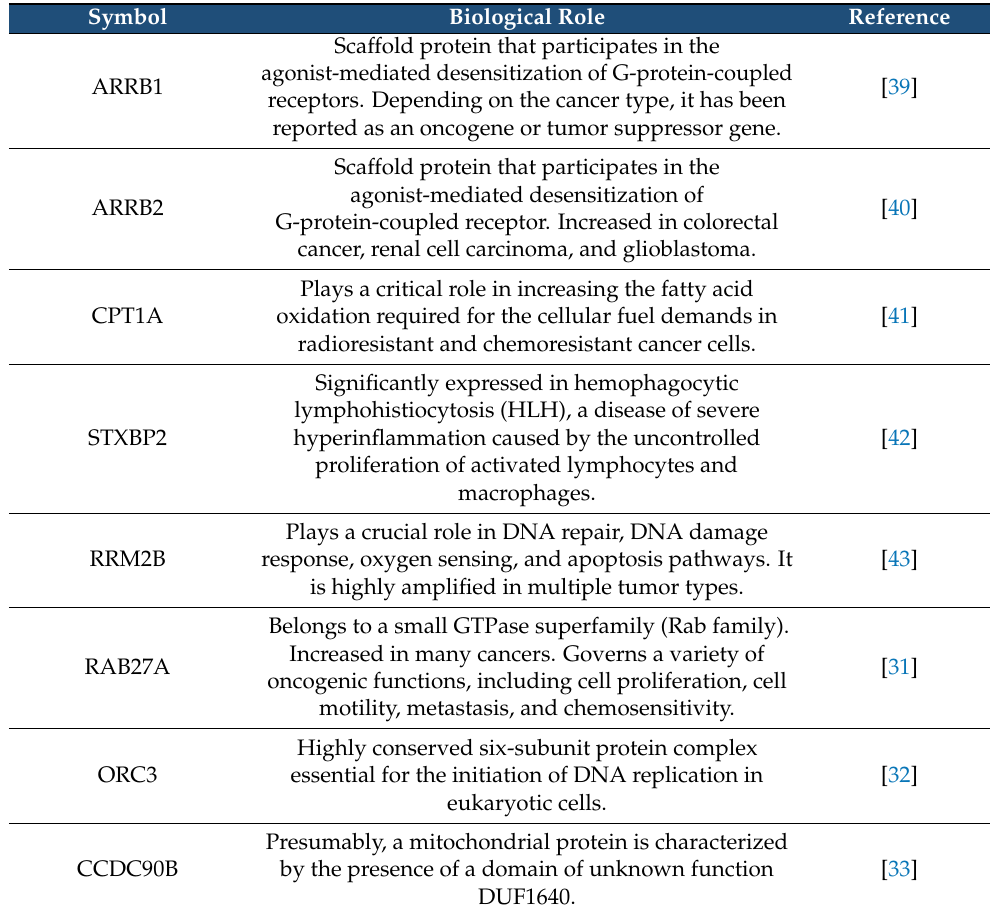
Table 7. Biological role of the top 20 differentially abundant proteins in RBPMS SG2 vs. EV